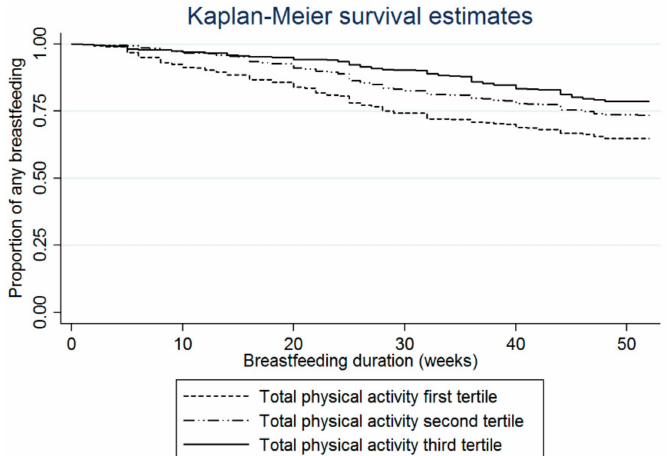
Figure 1. Kaplan-Meier curves of ‘any breastfeeding’ in the first twelve months postpartum for mothers with three di ff erent levels of physical activity (tertiles) during pregnancy (log-rank test p <